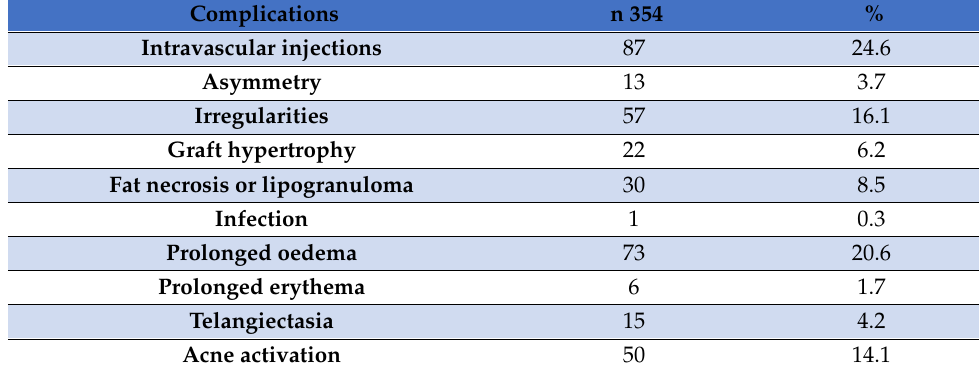
Table 3. resumes complications.